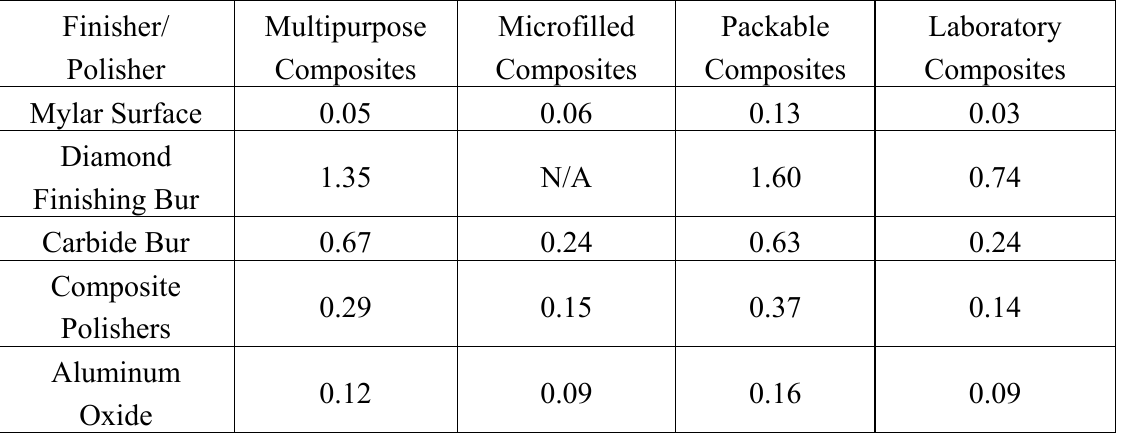
Table 1. Representative surface roughness ( μ m) of composites finished with various abrasives